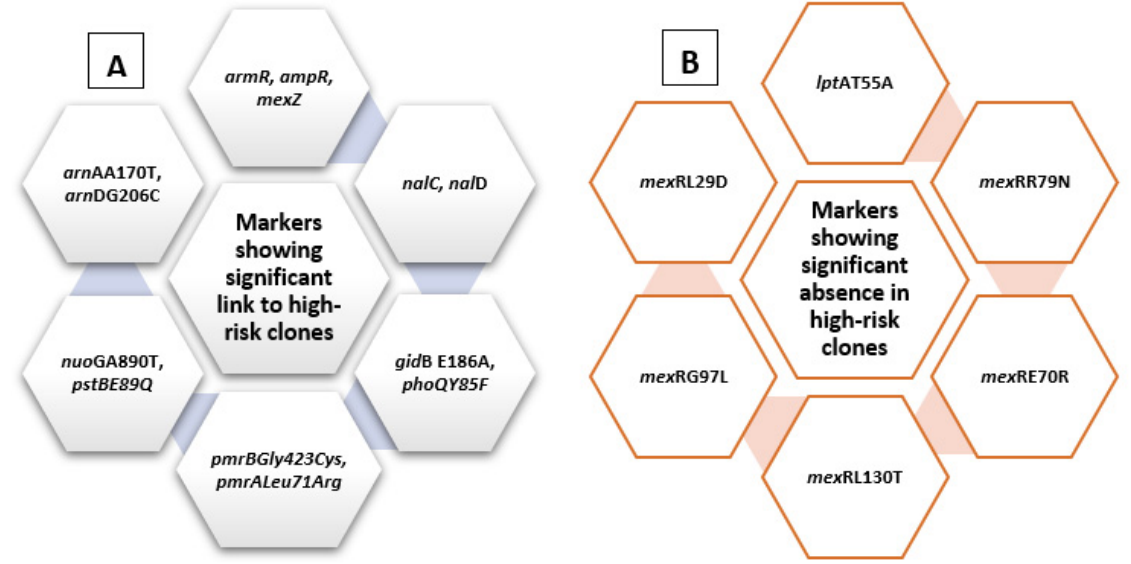
Figure 6. MST diagram showing distribution of amikacin susceptibility in relation to different STs. Red color: amikacin resistant ( n = 142); blue color: amikacin susceptible ( n = 386).